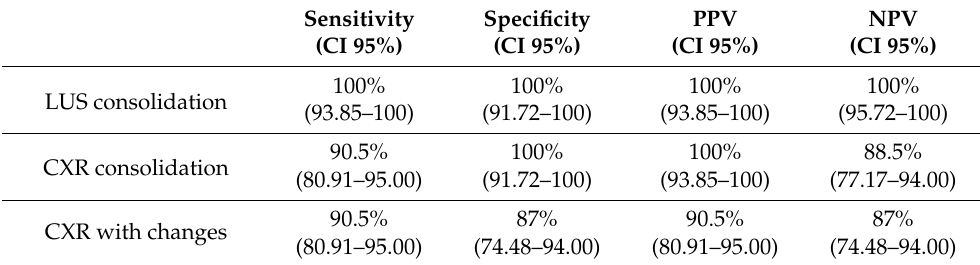
Table 3. Sensitivity and specificity of LUS compared to